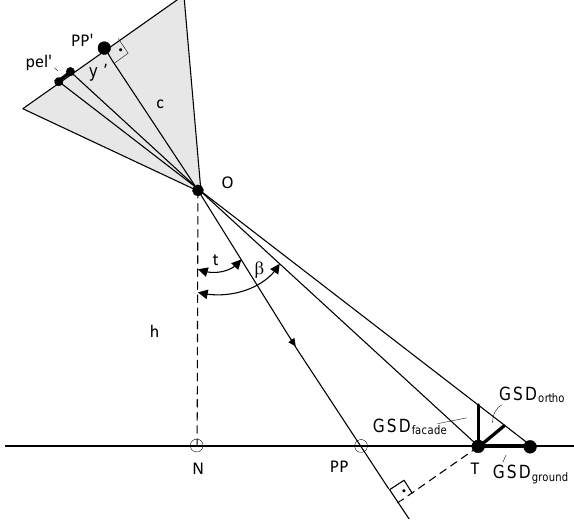
Figure 1. Variations in pixel size in oblique images. O…perspective centre, N…nadir point, PP’…principle point of image, T…target point, GSD…ground sampling